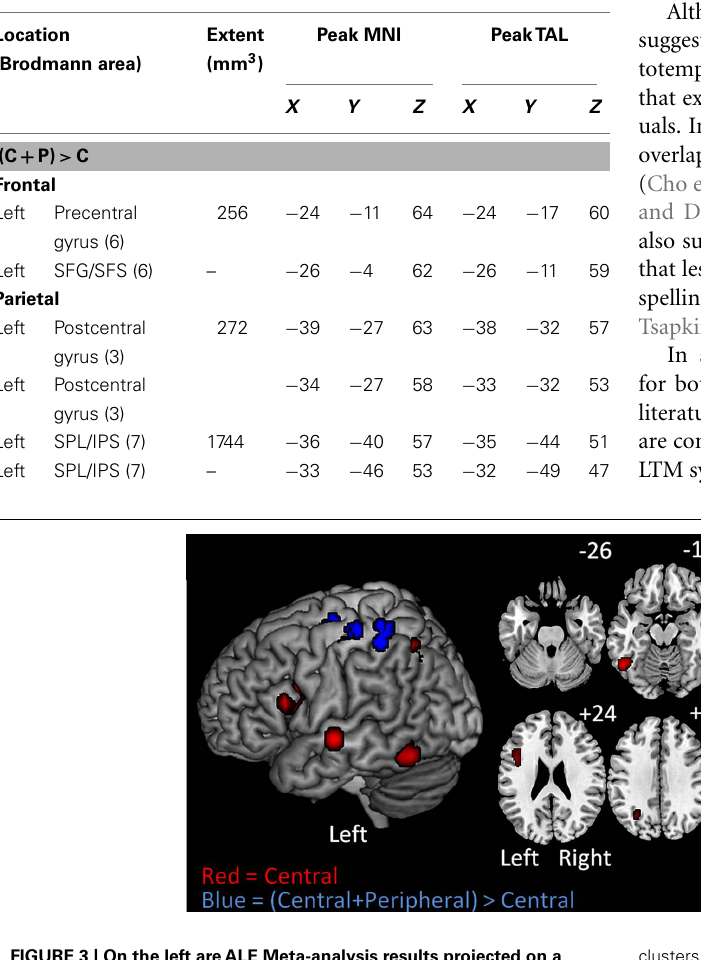
FIGURE 3 | On the left areALE Meta-analysis results projected on a standard rendered template brain and on the right are the corresponding axial slices from z − 26 to + 64 in 10mm increments. In red are the clusters corresponding to the central-contrast analysis.These